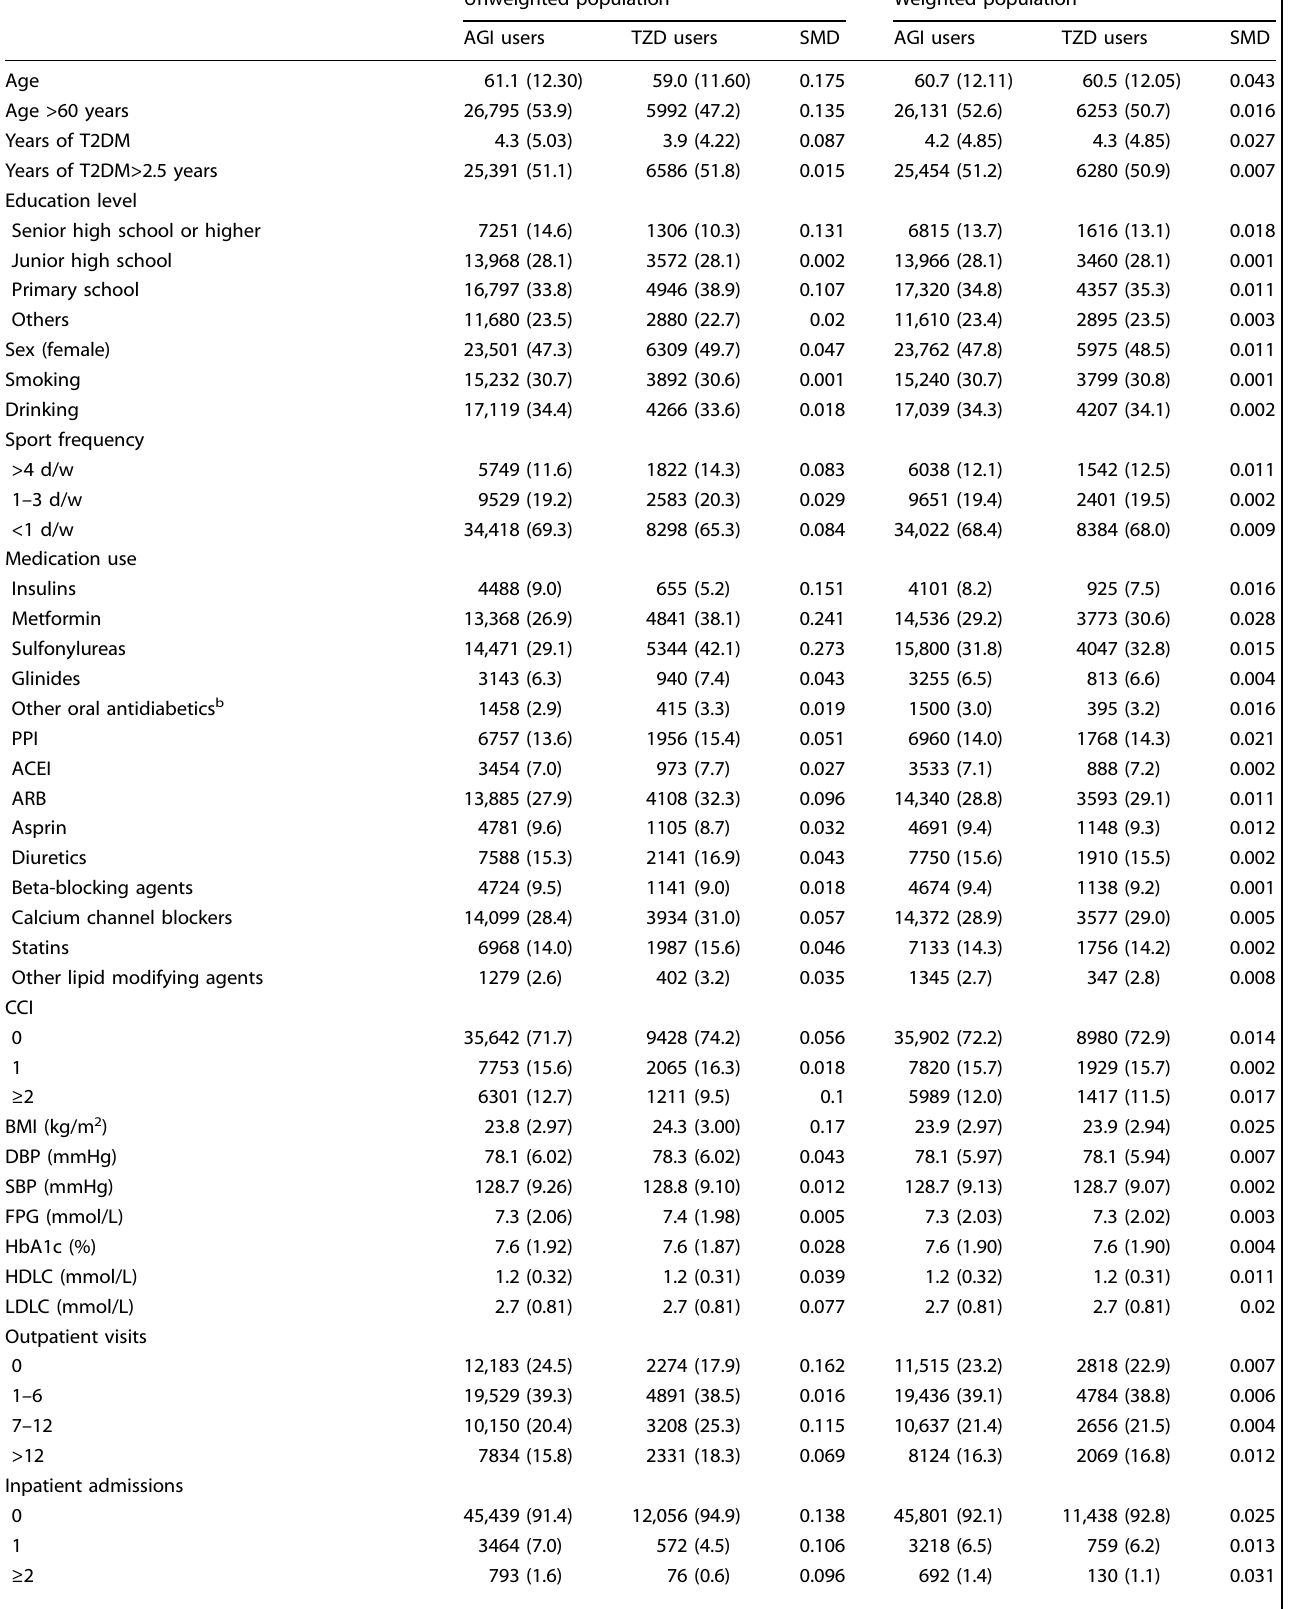
Table 1. Baseline covariates of new users of thiazolidinediones or alpha glucosidase inhibitors in the Yinzhou region a